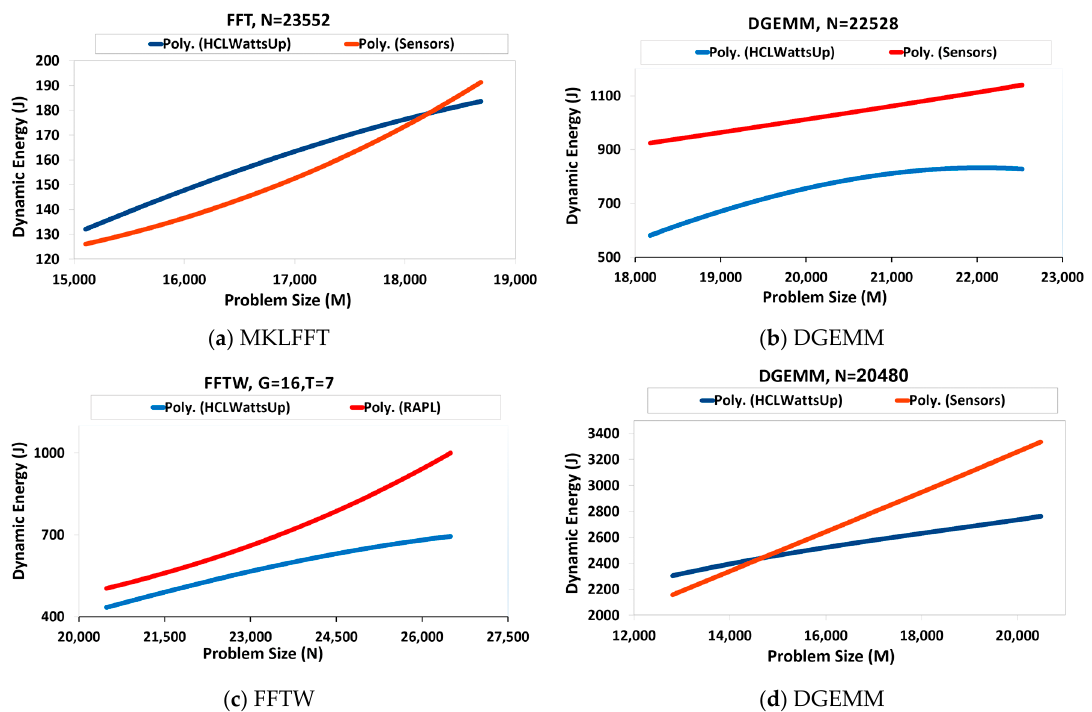
Figure 7. Group B (sets of single energy profile), class opposite similarity. Here G = CPU thread groups and T = CPU threads. Here, FFT refers to Fastest Fourier Transform; FFTW refers to Fastest Fourier Transform in the West; and DGEMM refers to Double-precision General Matrix Multiplication.